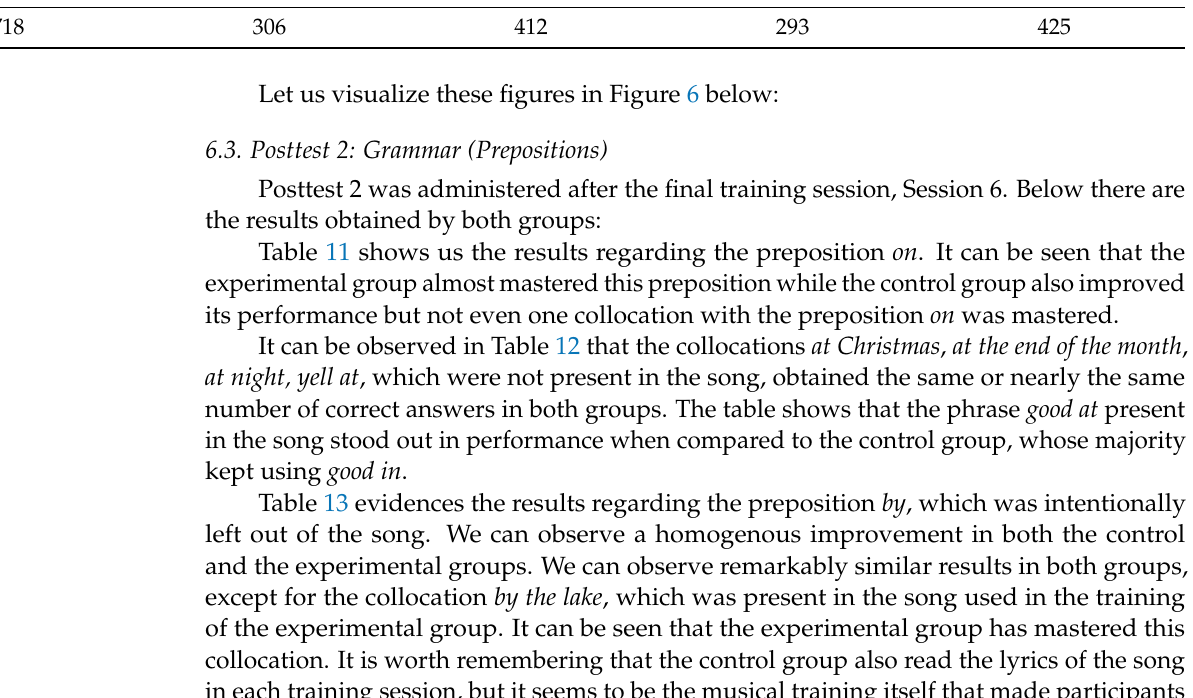
Figure 6. Posttest 1: Percentage of correct answers regarding gender and education.